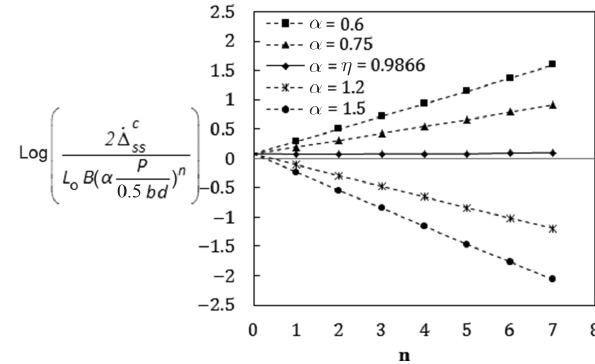
Figure 5: Determination of β and η for